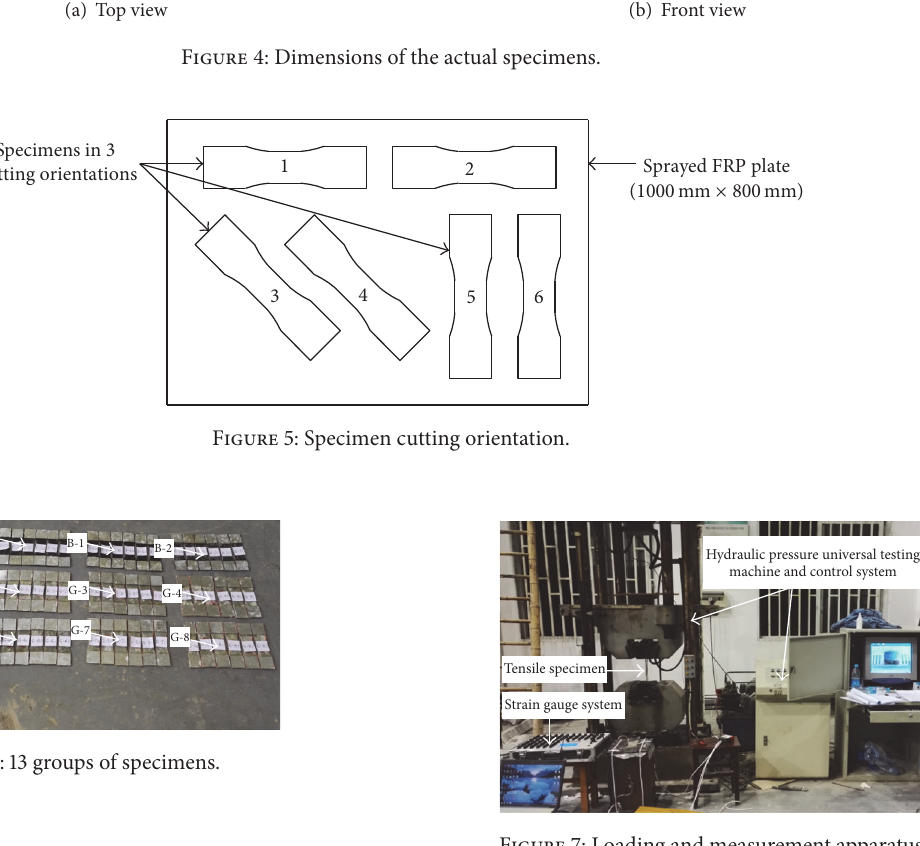
Figure 7: Loading and measurement